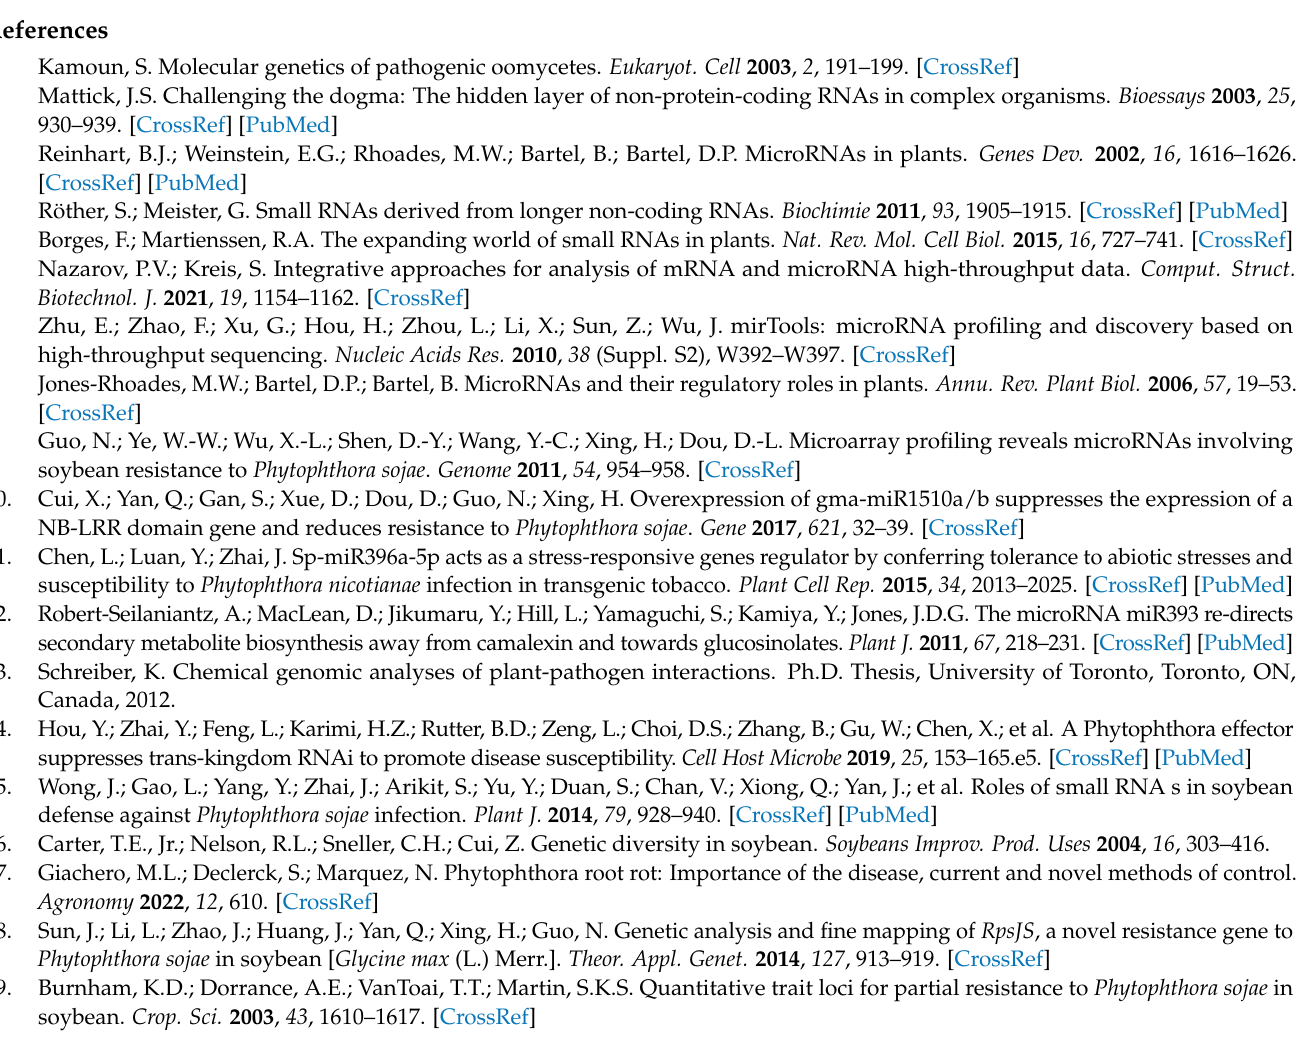
samples, Figure S5: Differentially expressed miRNA volcano map, Figure S6a-b: Plant–hormone signaling pathway in S01 vs. S02 along with their DEGs, Figure S7: Cyanoamino acid metabolism showing the downregulated DEGs in S01 vs. S02 and S03 vs. S04, Figure S8: KEGG pathway of phenylpropanoid biosynthesis for differentially expressed miRNA target genes in S01 vs. S02 and S03 vs. S04, Figure S9: Plant–pathogen interaction pathway in S01 vs. S02 and S03 vs.